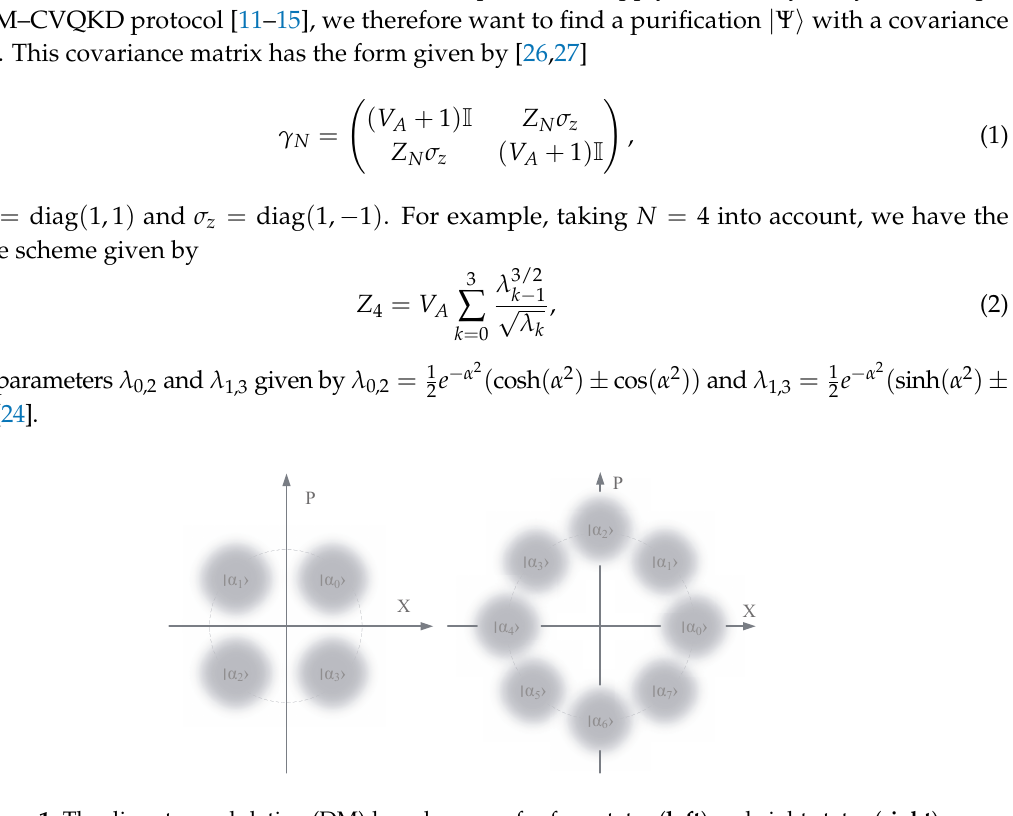
Figure 1. The discrete-modulation (DM)-based sources for four states ( left ) and eight states ( right ).